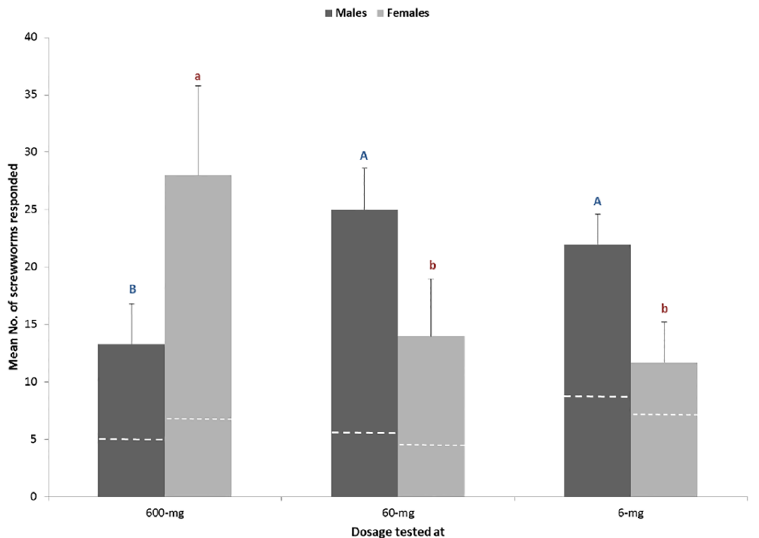
Fig 3. Behavioral responses of adult screwworms to the synthetic blends of a 5-component blend at three dosages of 600 mg, 60 mg and 6 mg in the laboratory assay (Mean number of screwworm flies ± Std. Error). Different letters above the bars indicate significantdifferences in captures of male and female flies (ANOVA, followedby LSD, P < 0.05). Dashedlines indicatemean numberof flies caught from the controls.